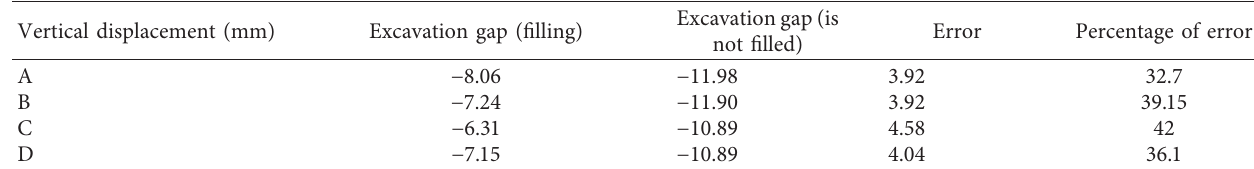
Table 5: Sewage pipe measuring point vertical displacement.